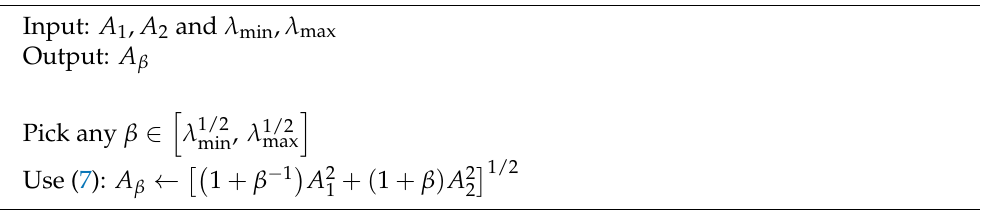
Algorithm A3 Function: Compute a Kurzhanski’s outer bound